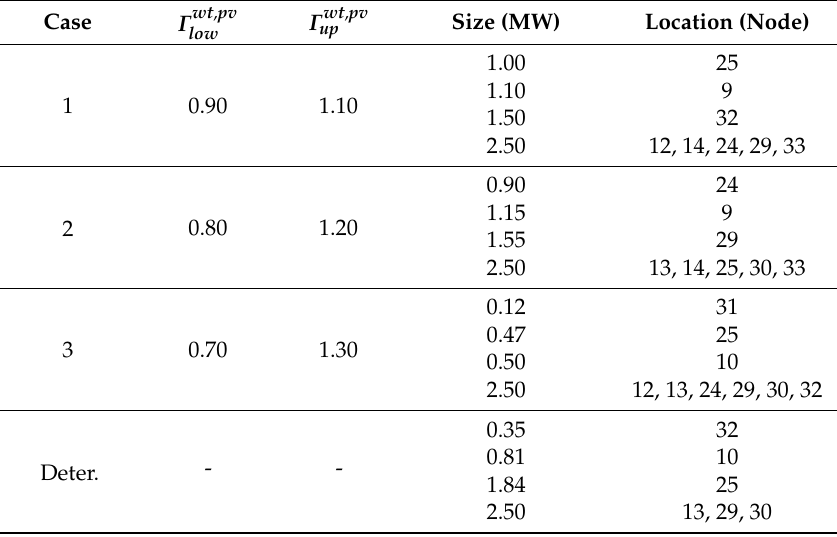
Table 4. Distributed generators’ deployments in different cases. Table 2. Parameters for corresponding costs.